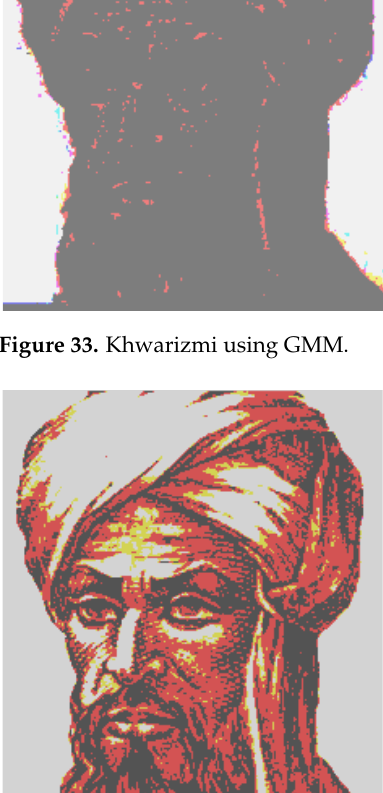
Figure 32. Archimedes using FP-Conv-CM .